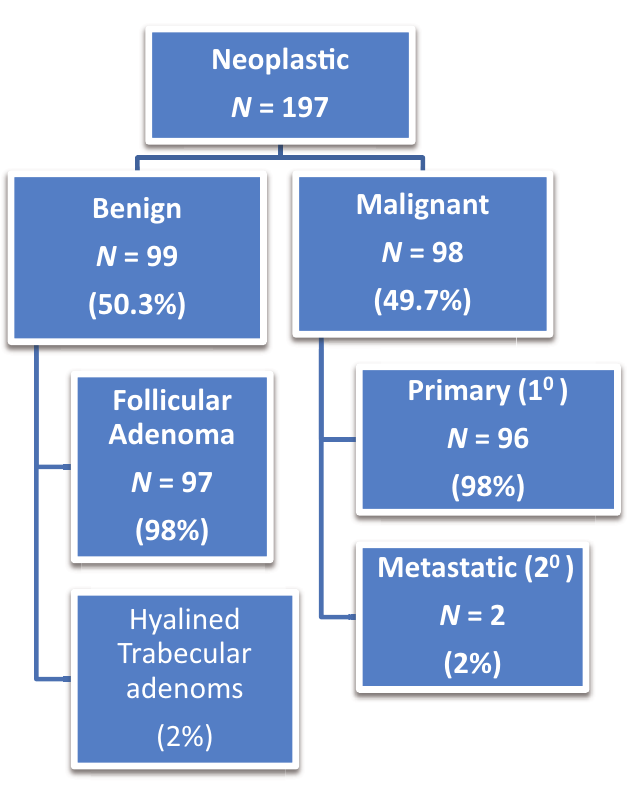
Figure 3 : Neoplastic thyroid disease.